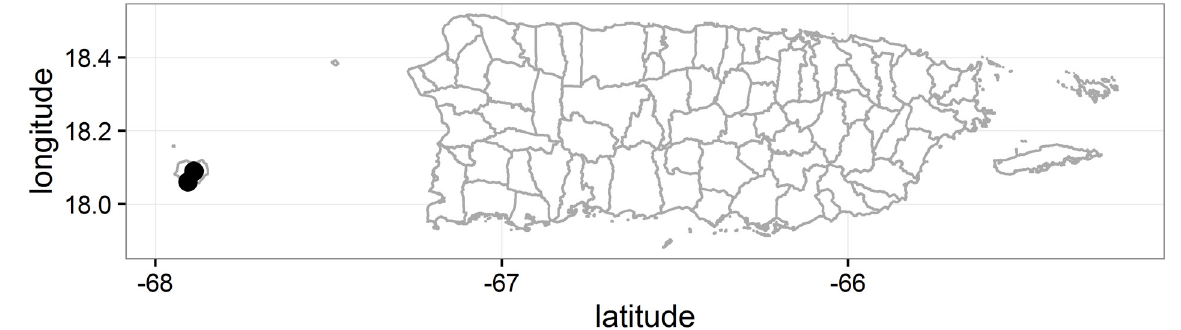
Fig. 8. Distribution map for Lasioglossum amona sp.